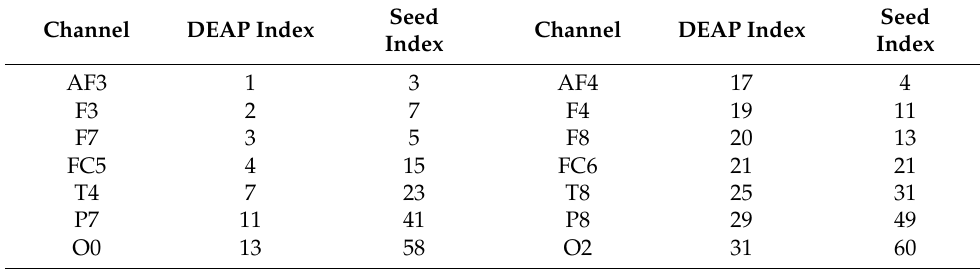
Table 1. Channel